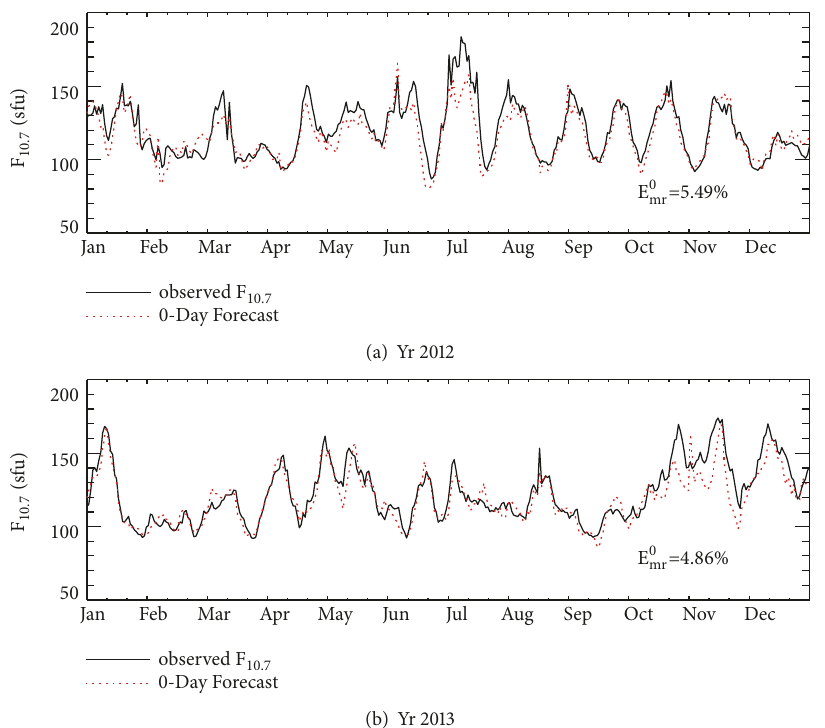
Figure 7: A comparison of 0-day predictive (dotted red line) and observed (solid black line) F 10.7 in 2012 (a) and 2013 (b).